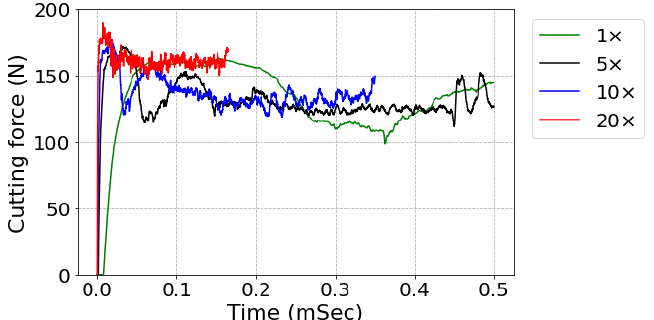
Figure 8. Cutting force comparison at different speeds for 2D model. To reduce the simulation time, evaluation of the effect of increasing cutting speeds on the simulated cutting force is